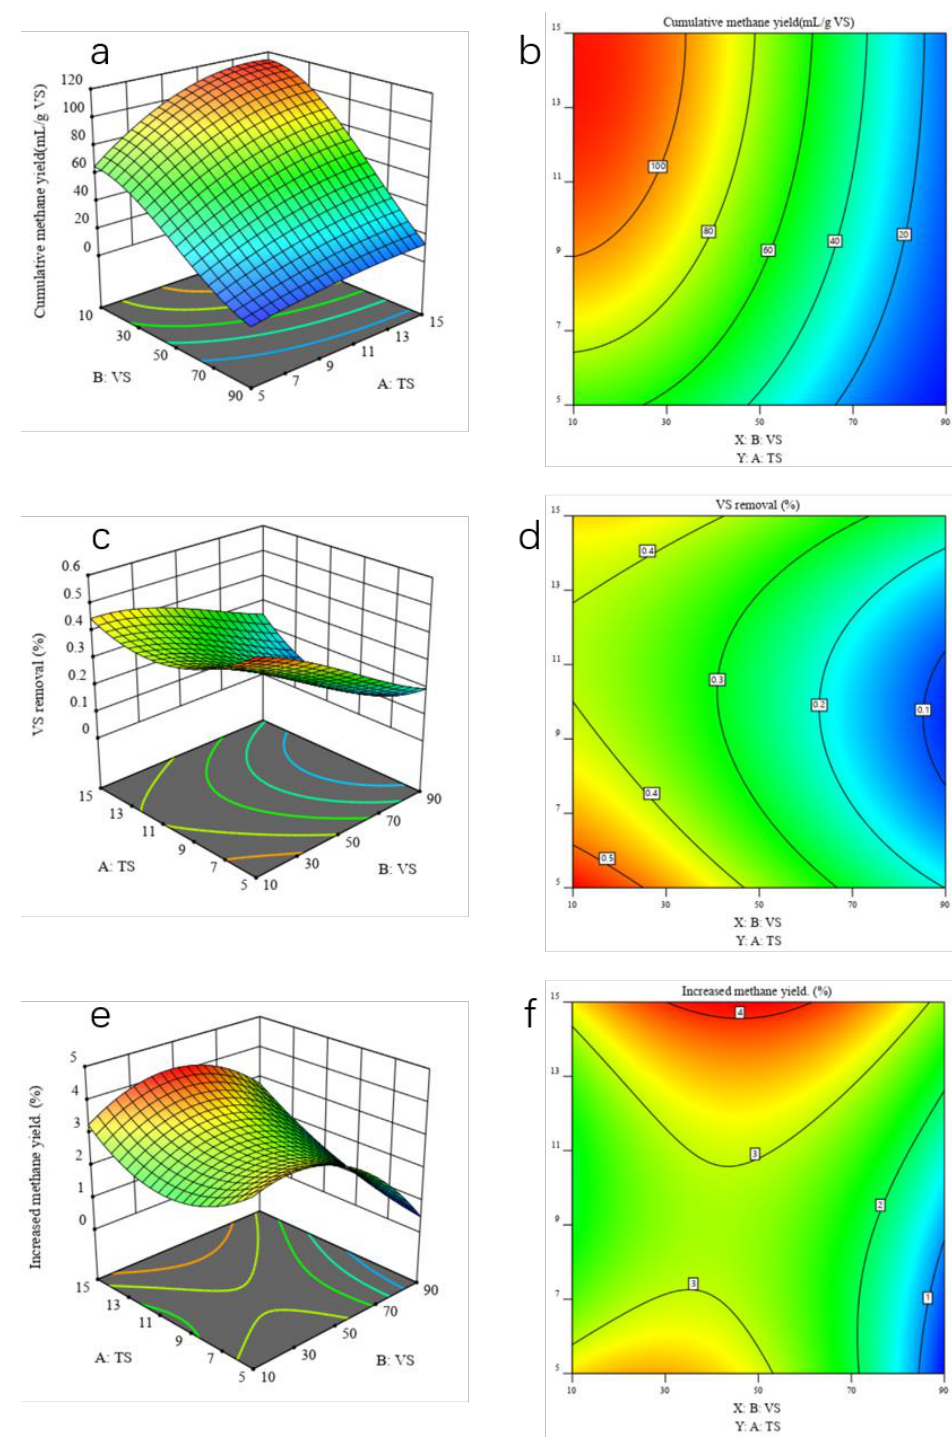
Figure 6. Response surface plot and contour plot of TS and ratio. ( a , b ) response surface plot and contour plot for cumulative methane yield; ( c , d ) for VS removal; ( e , f ) for increased methane yield.